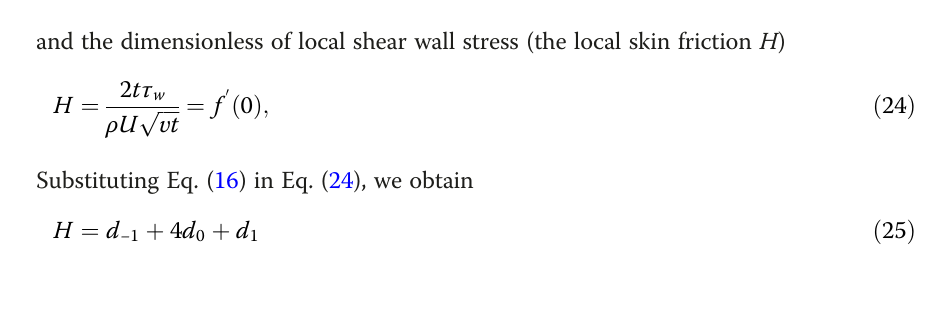
(ii) The local surface heat flux q